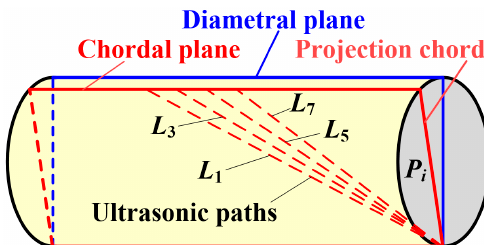
Figure 3. Illustration of the individual ultrasonic paths and their corresponding projection chords on the cross-sectional area of a pipe, showing that ultrasonic paths (1,3,5,7) are in the same chordal plane and correspond to the same correction factor in a fully developed, undisturbed flow profile.